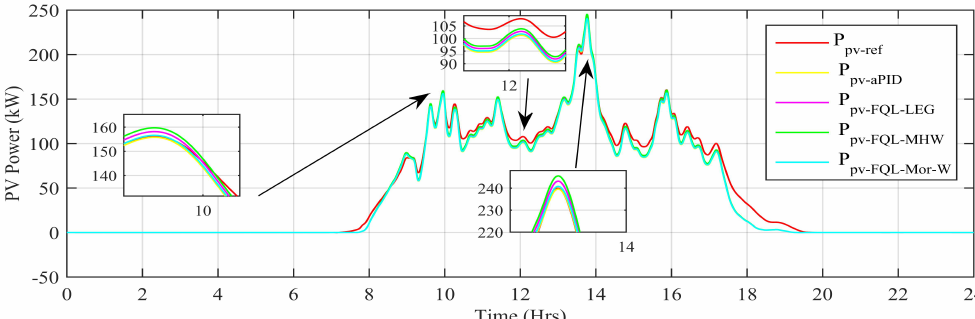
Figure 18. Maximum power point tracking of PV array evolution.